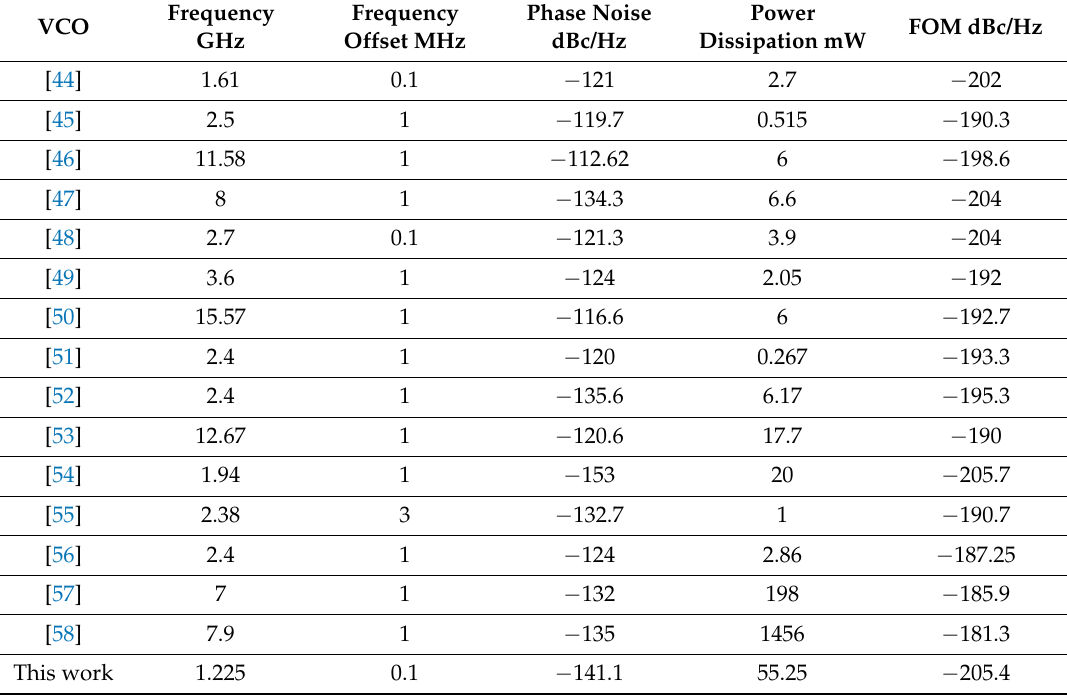
Table 4. Performance of designed VCO and some recently published